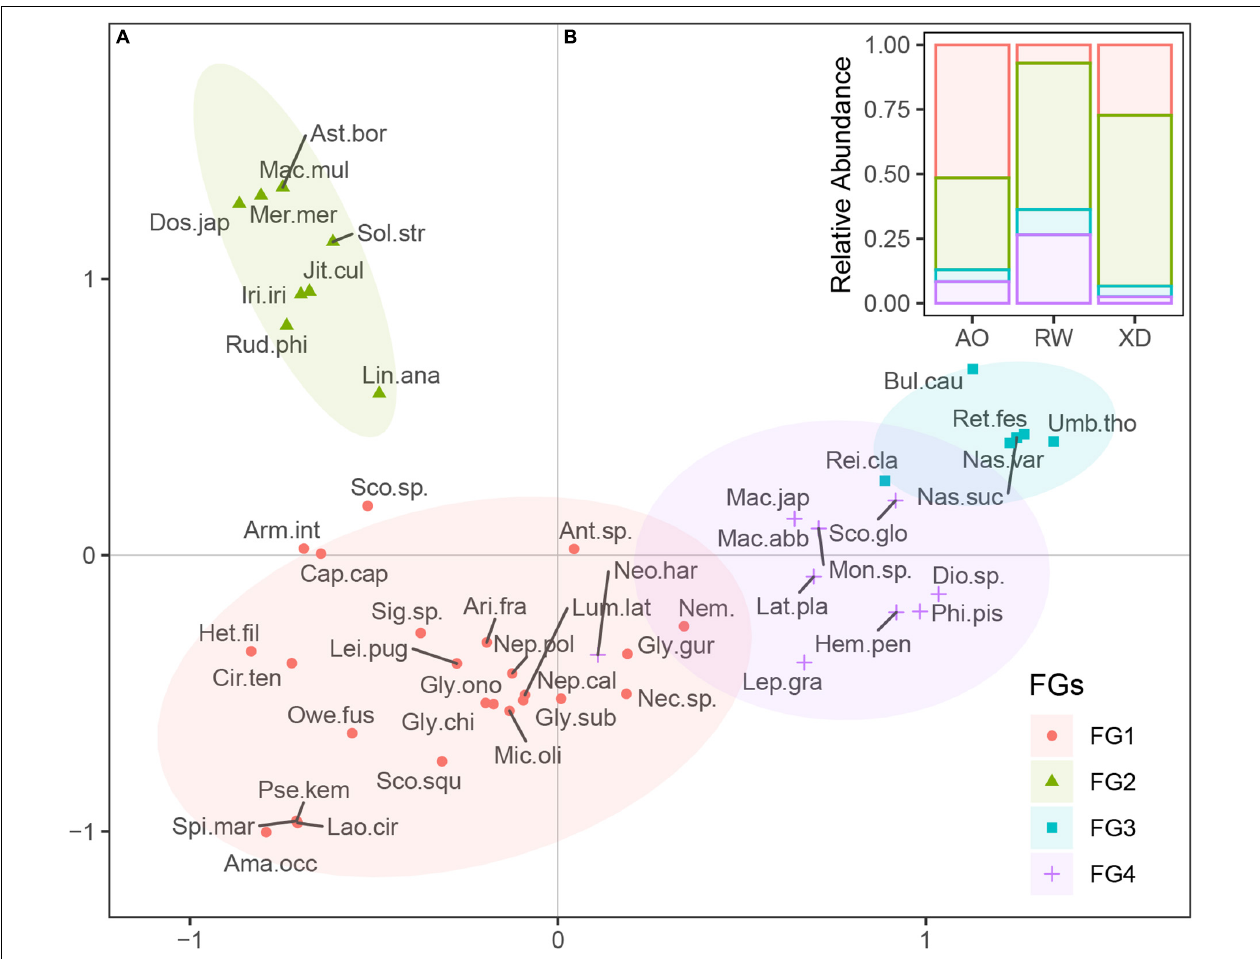
FIGURE 6 | Functional groups of macrobenthos. (A) Distribution of the taxa on the first two axes of FCA, taxa were clustered into four groups; (B) the relative abundance of four functional groups species in three intertidal communities. FGs, functional groups; For full names of species, see Supplementary Table 1 .